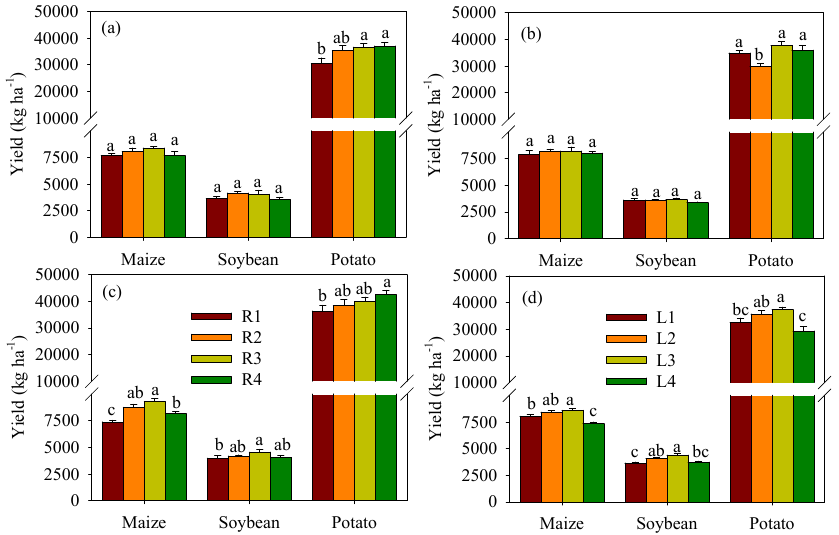
Figure 3. Crop yields in di ff erent treatments over the two growing seasons of 2016 ( a , b ) and 2017 ( c , d ). Di ff erent lowercase letters indicate significant di ff erences among the di ff erent treatments.